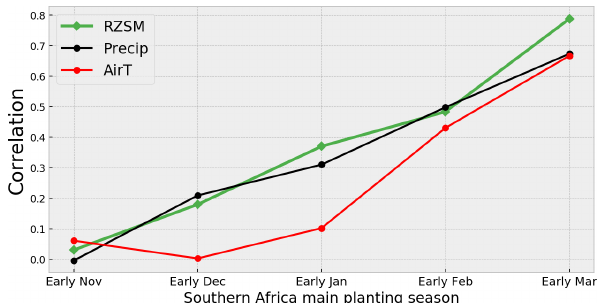
Figure 5. Variability in the correlation between the 3-month sea- sonal precipitation, 3-month seasonal air temperature (AirT), and monthly RZSM monitoring product with the detrended crop yield. This result highlights that RZSM is potentially a better predictor of crop yield than seasonal precipitation and AirT; also, the skill is the highest in early March when DJF seasonal precipitation, AirT, and February RZSM monitoring products are